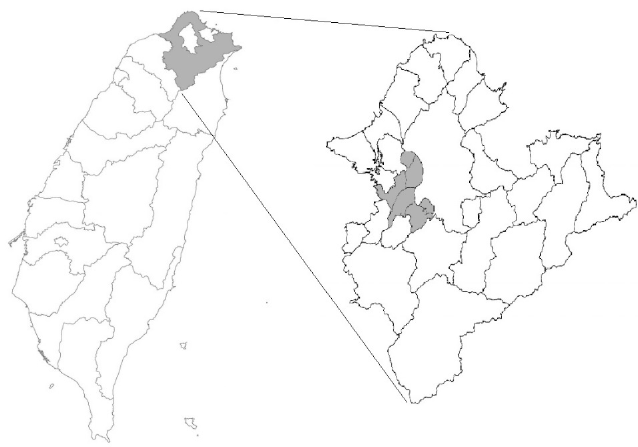
Figure 1. The map of Taiwan with New Taipei City in gray area (left). Residents lived in the metropolitan area of the city were included in the study (right).